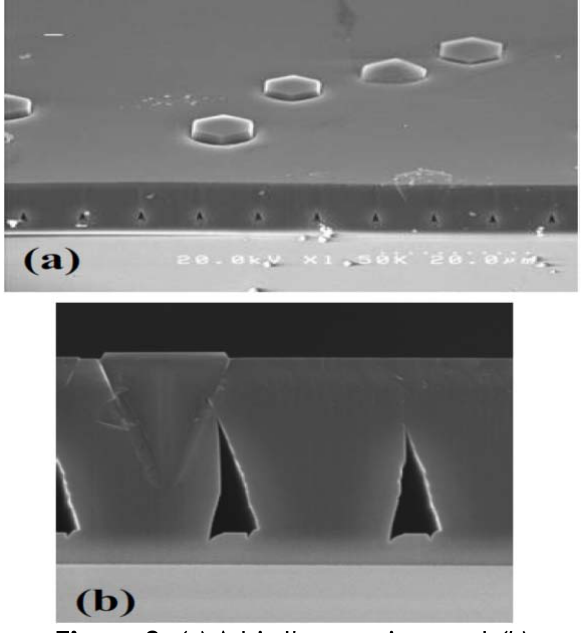
Figure 8. (a) A bird's-eye view and (b) a cross-sectional image of the abnormal AlN cores generated on ELO-AlN layer observed by HR-SEM